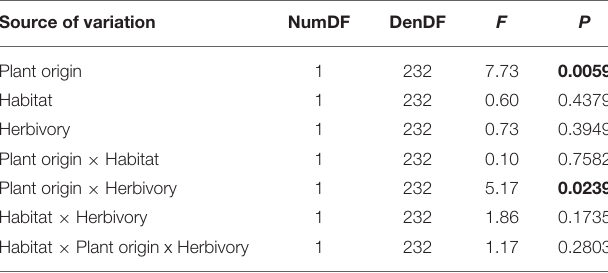
TABLE 1 | Results of linear mixed-effects model for PSFs.